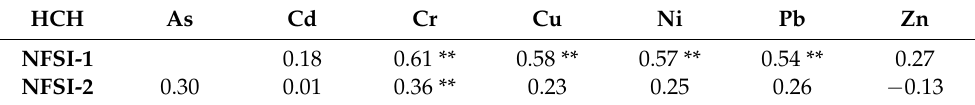
Figure 4. Percentage cumulative frequency distribution of the HCH concentrations (sum of α -HCH, β -HCH, γ -HCH) of the nationwide NFSI sample in the humus layer; plots of the NFSI in Brandenburg are indicated by green circles. Table 7. Correlation coefficients between HCH concentrations (sum of α -HCH, β -HCH, γ -HCH) and the As, Cd, Cr, Cu, Ni, Pb and Zn concentrations in the humus layers from Brandenburg NFSI plots differentiated for data from NFSI-1 (n = 36) and NFSI-2 (n = 50); significance: ** p <